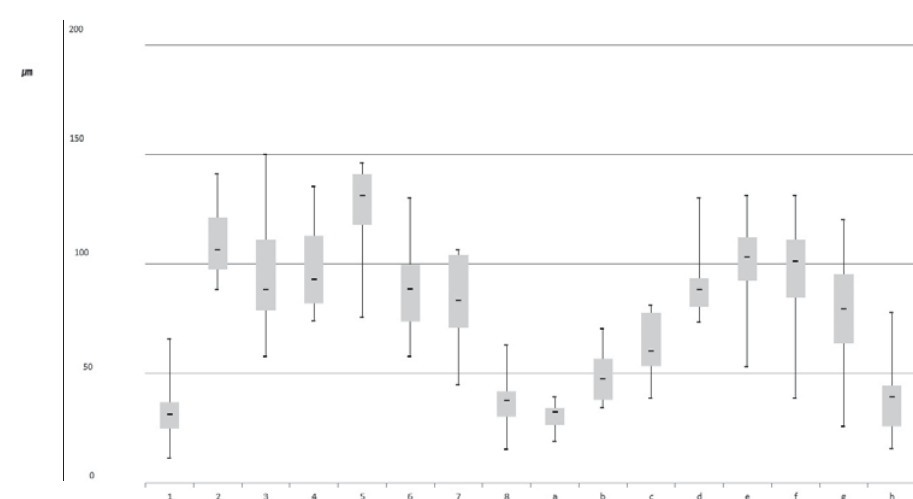
Figure 3- (cid:3)(cid:36)(cid:70)(cid:70)(cid:88)(cid:85)(cid:68)(cid:70)(cid:92)(cid:3)(cid:82)(cid:73)(cid:3)(cid:191)(cid:87)(cid:3)(cid:82)(cid:73)(cid:3)(cid:72)(cid:68)(cid:70)(cid:75)(cid:3)(cid:80)(cid:72)(cid:68)(cid:86)(cid:88)(cid:85)(cid:76)(cid:81)(cid:74)(cid:3)(cid:83)(cid:82)(cid:76)(cid:81)(cid:87)(cid:3)(cid:76)(cid:81)(cid:3)(cid:74)(cid:85)(cid:82)(cid:88)(cid:83)(cid:3)(cid:20)(cid:3)(cid:11)(cid:38)(cid:40)(cid:53)(cid:40)(cid:38)(cid:3)(cid:54)(cid:58)(cid:3)(cid:22)(cid:17)(cid:27)(cid:15)(cid:3)(cid:23)(cid:19)(cid:3) (cid:80) m). Uppermost point and lowermost point indicate the highest and lowest values of results. The top of box and bottom of box indicate the 75% and 25% values of results. The midline in the box means the average of the results